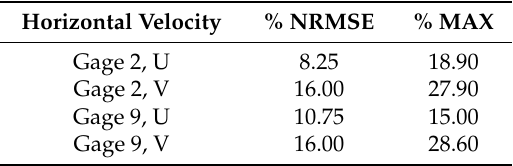
Table 2. Error statistics of numerical results for horizontal velocity time series recorded at each